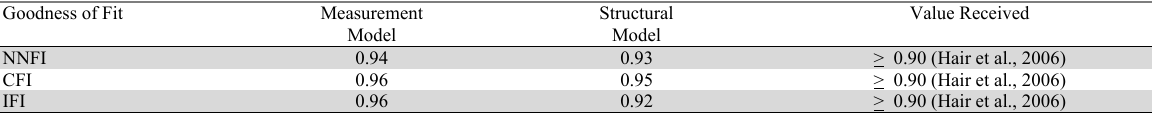
The Goodness of Fit Measurement Model and Structural